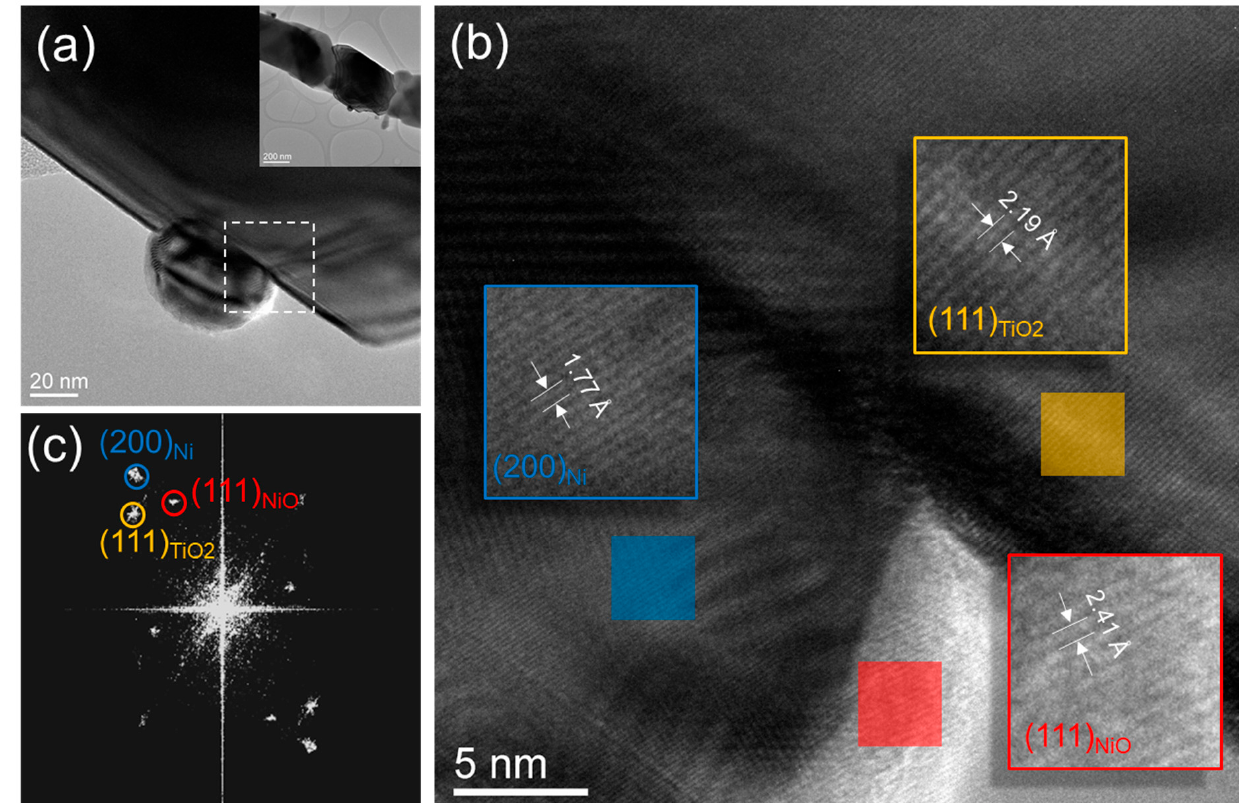
Figure 8. ( a ) TEM image of Ni nanoparticles on TiO 2 nw in the spent catalyst. A low magnification of this segmented nanowire is shown in the inset. ( b ) high resolution TEM image of the interfacial area shown with a dotted square line in ( a ). ( c ) Fast Fourier Transform (FFT) of the high resolution TEM image shown in ( b ). Reflection spots corresponding to TiO 2 nw, Ni np, and NiO shells are marked using yellow, blue, and red circles, respectively.